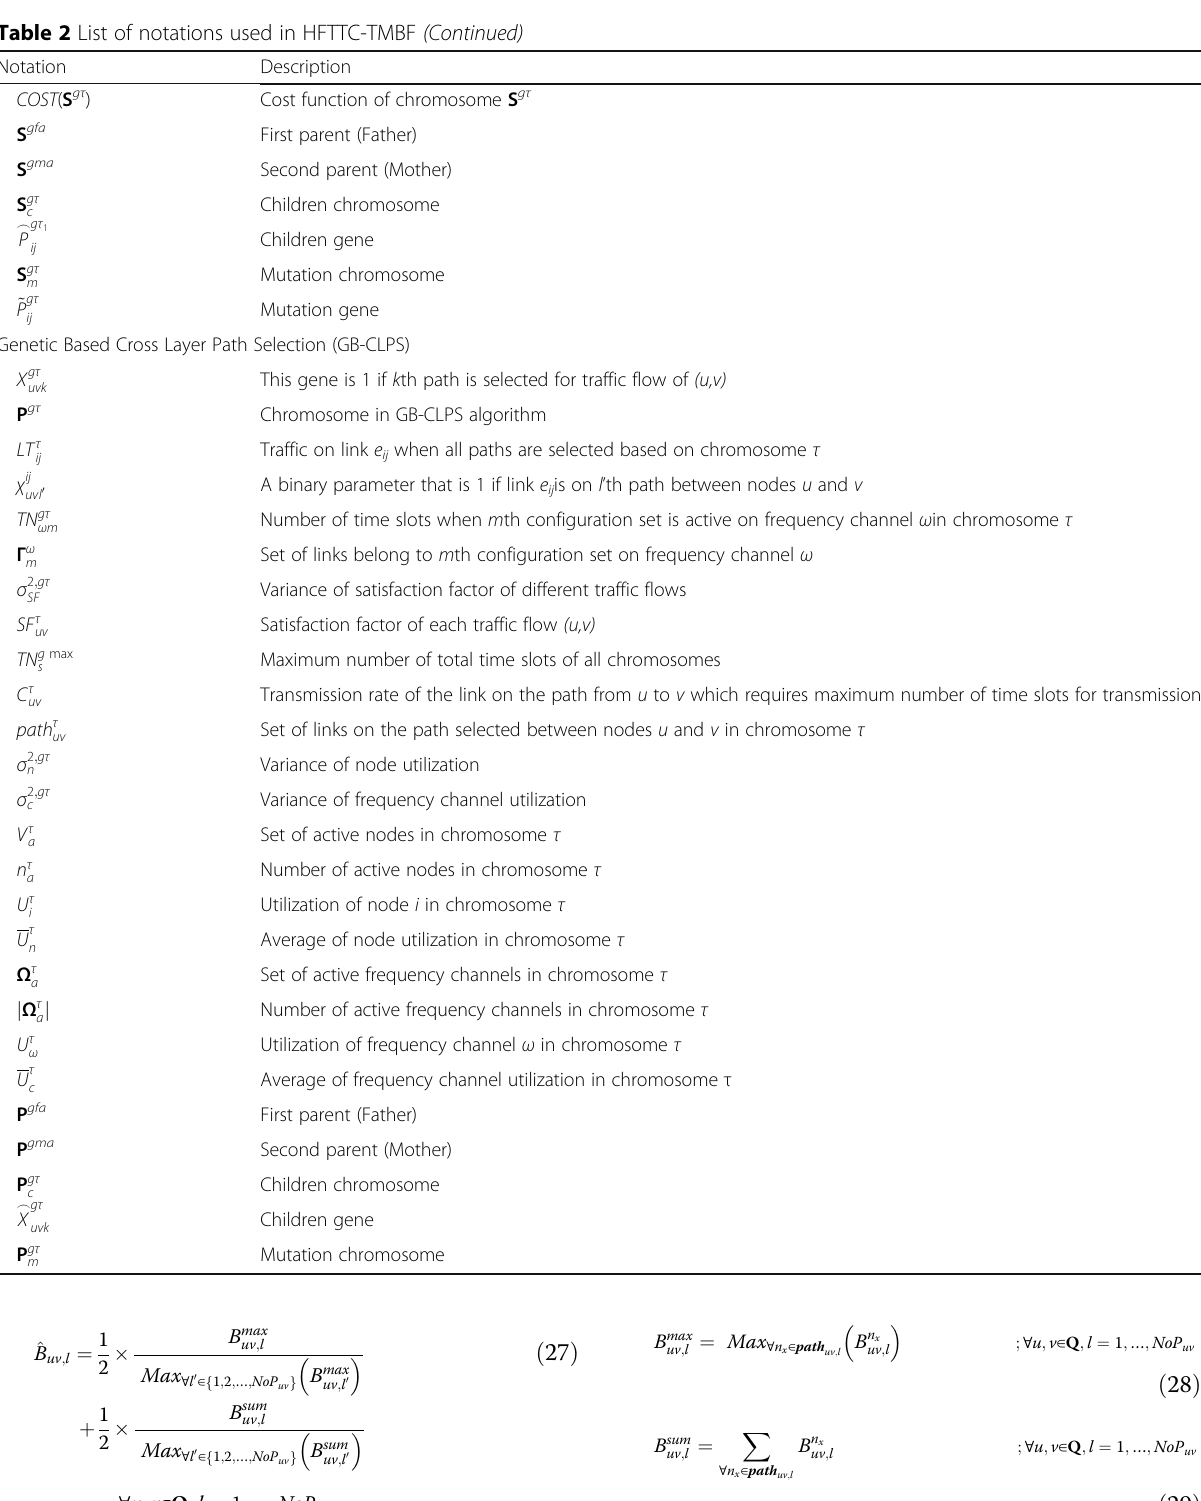
Table 2 List of notations used in HFTTC-TMBF